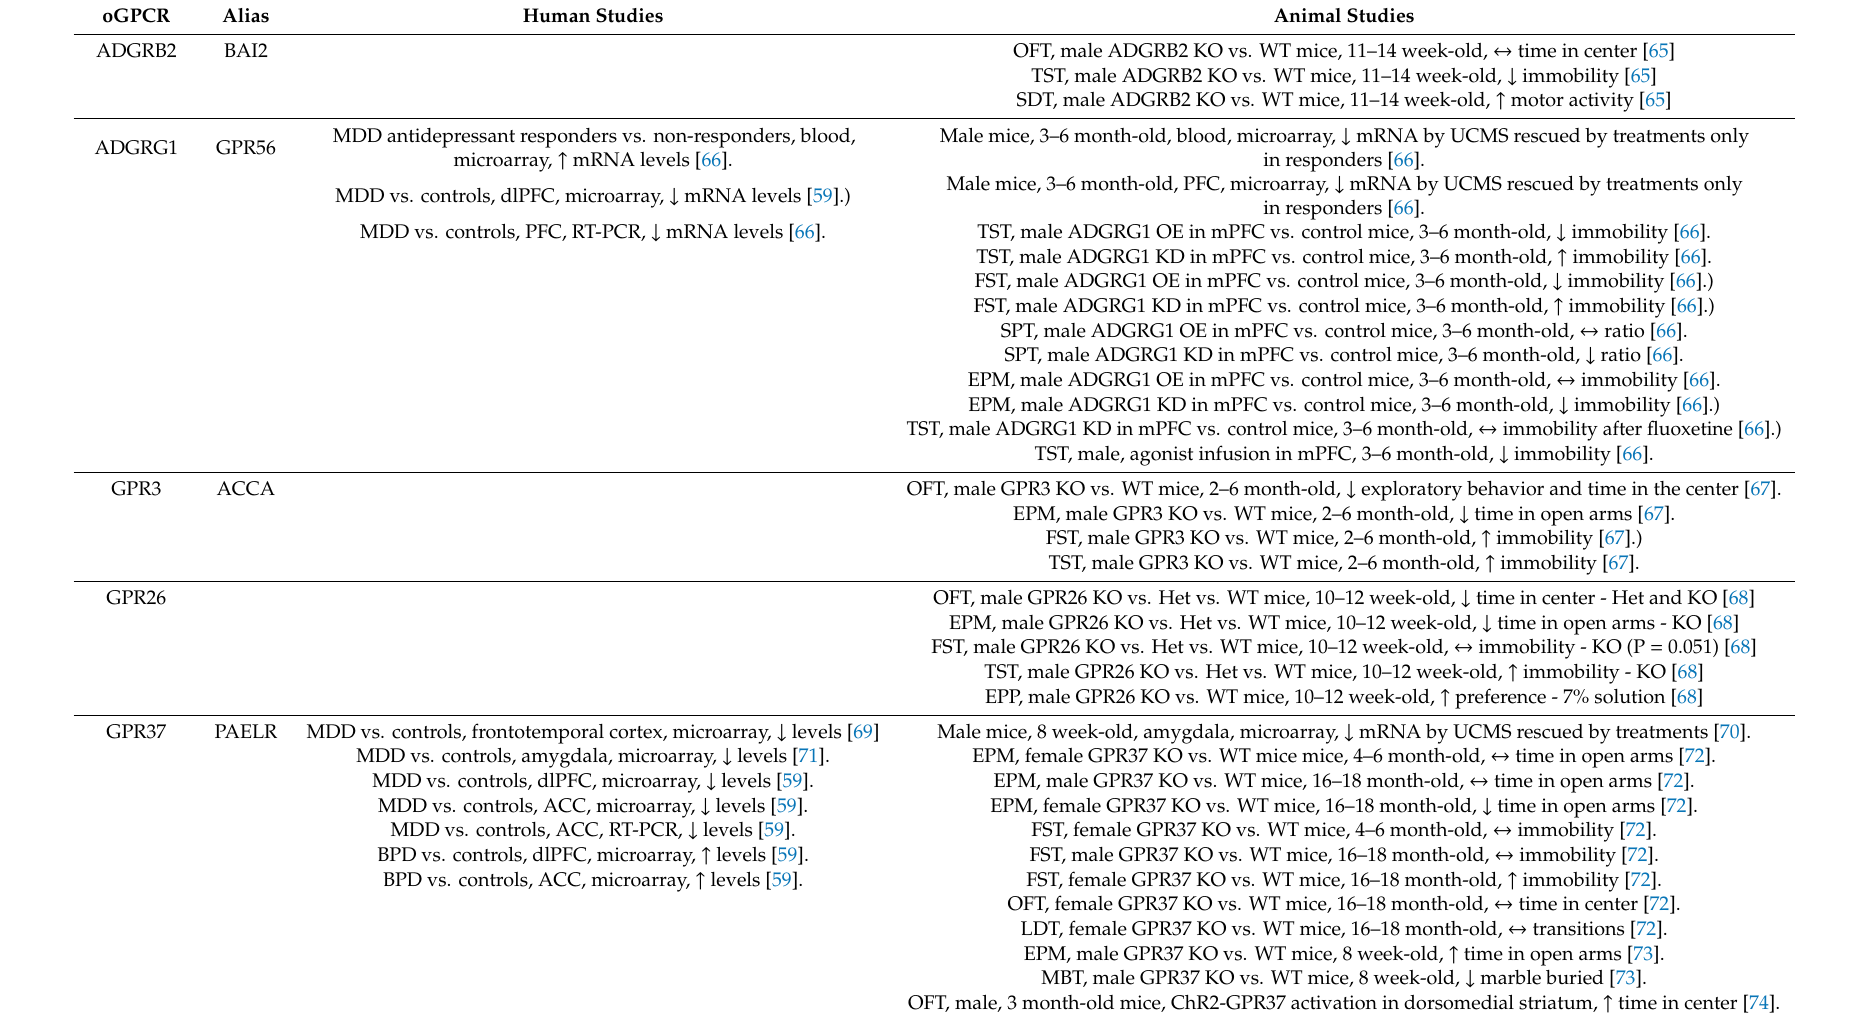
Table 1. Results of human and animal studies indicating the involvement of oGPCRs in mood and anxiety disorders. oGPCR Alias Human Studies Animal Studies ADGRB2 BAI2 OFT, male ADGRB2 KO vs. WT mice, 11–14 week-old, ↔ time in center [65]